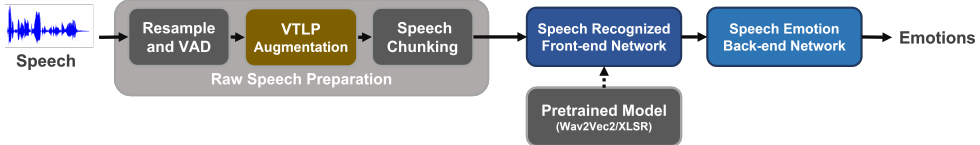
Figure 1. Real-time E2ESER-CD